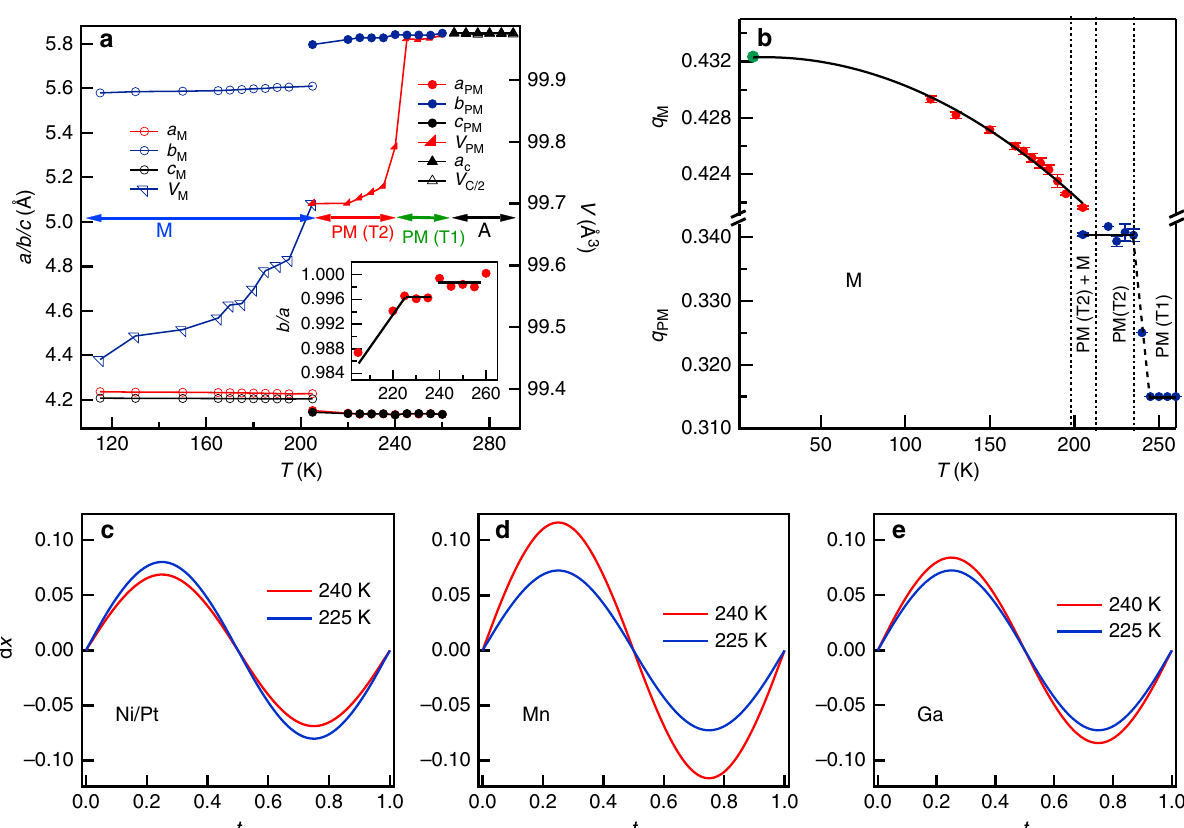
Fig. 6 Temperature variation of the re fi ned parameters. The parameters obtained from Rietveld re fi nements are plotted in a lattice parameters a , b , c , and volume in the austenite (A), 3M-like premartensite (PM), and the 7M-like martensite (M) phase regions for the cooling cycle. The volume of cubic phase is scaled with 1/2 for comparison. Inset shows the variation of b/a ratio (Bain distortion) with temperature in PM (T1) and PM (T2). Subscript c, PM, and M are used for austenite cubic, PM, and M phases, respectively. b Variation of magnitude of modulation vector ( q ) as a function of temperature obtained from superspace Rietveld re fi nements during cooling; c – e show the comparison of displacement (d x ) with t parameter between PM (T1) at 240 K and PM (T2) at 225